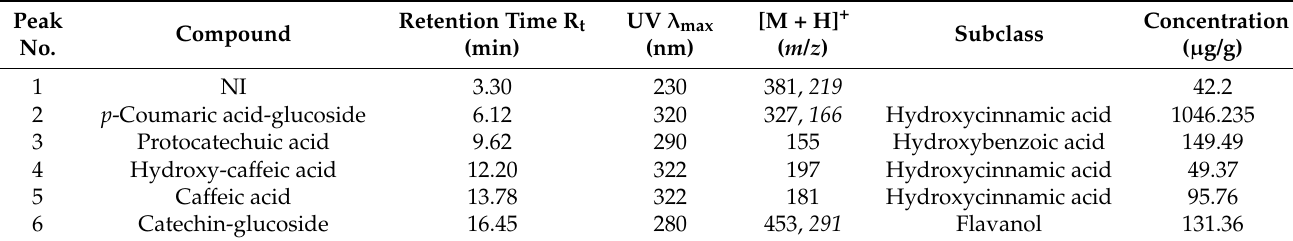
Table 3. Quantification and identification of phenolic compounds ( µ g/g FWA) by HPLC-DAD- ESI+